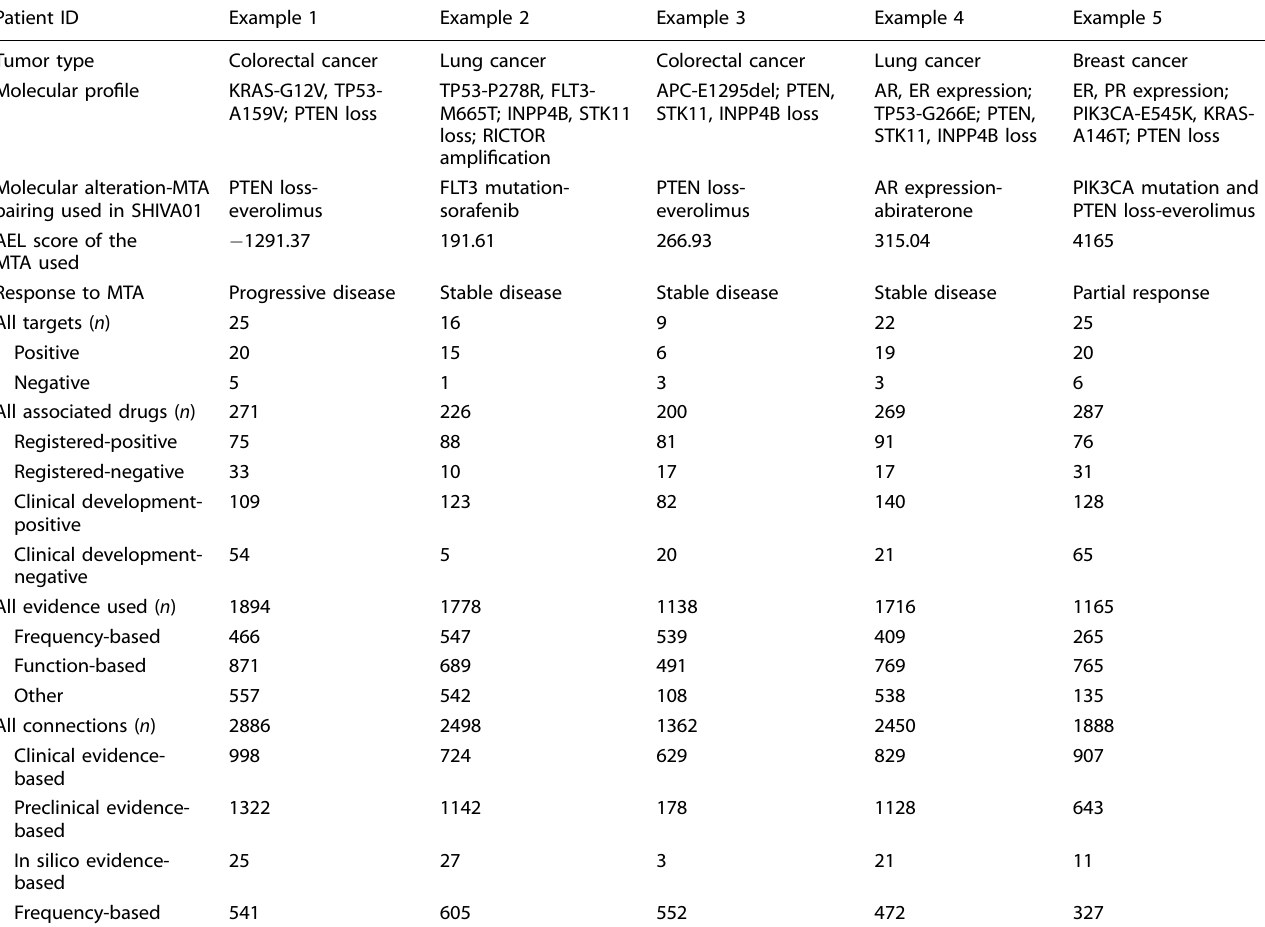
Table 1. Digital drug assignment (DDA) of fi ve examples cases of patients treated in the SHIVA01